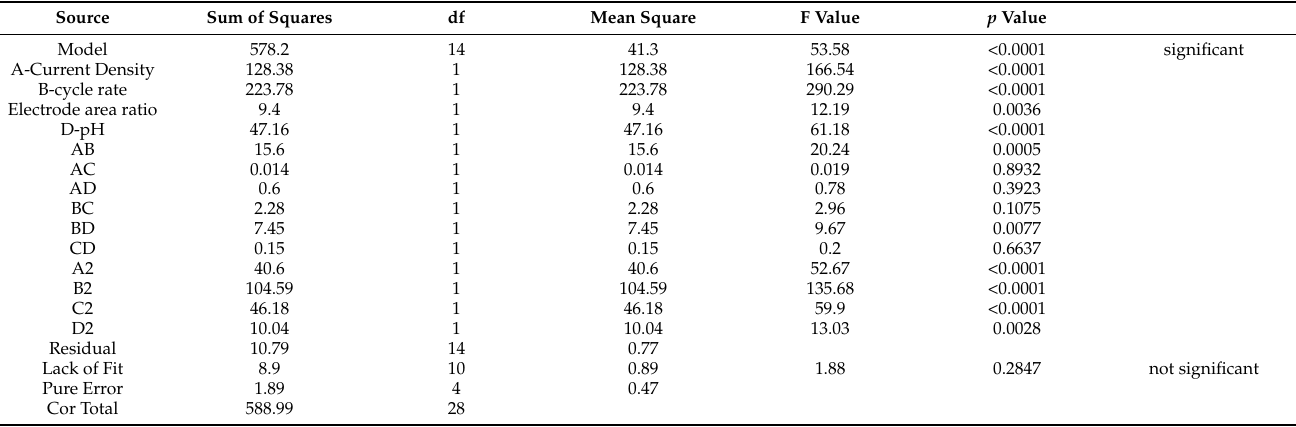
Table 6. The analysis of